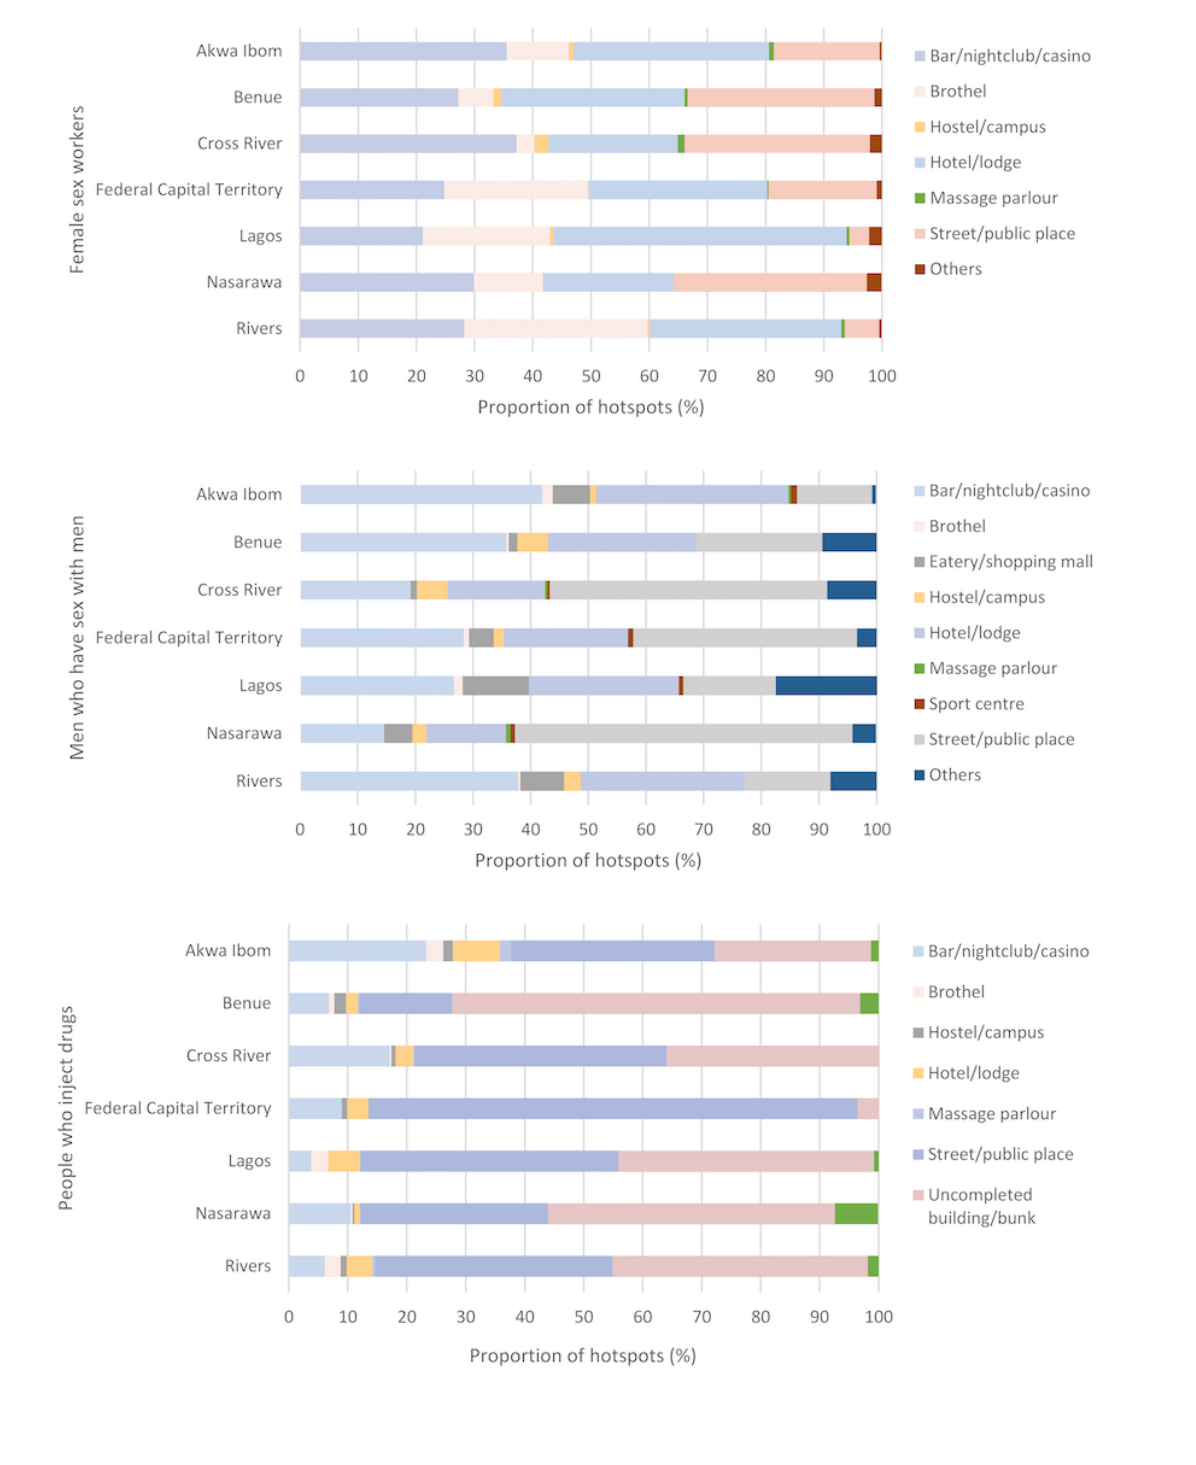
Figure 2. Type of key population hotspots by